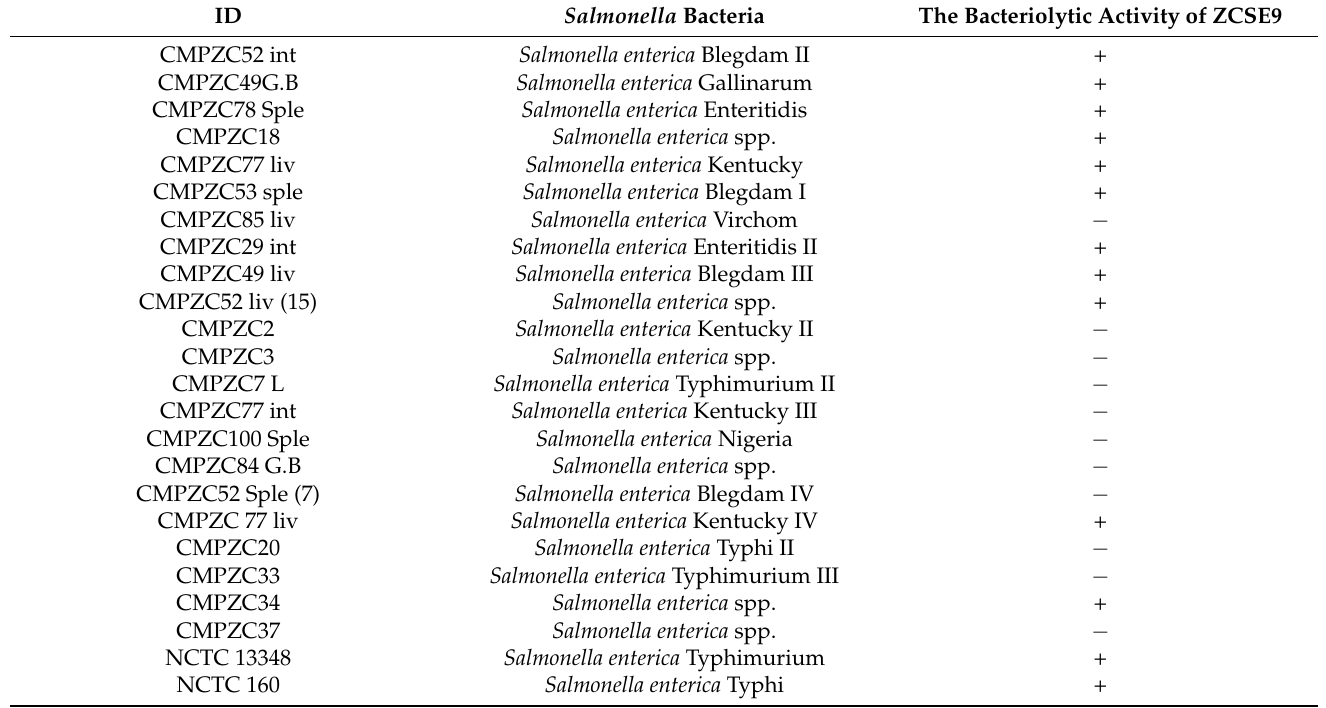
Table 1. Lytic activity of phage ZCSE9 against Salmonella enterica